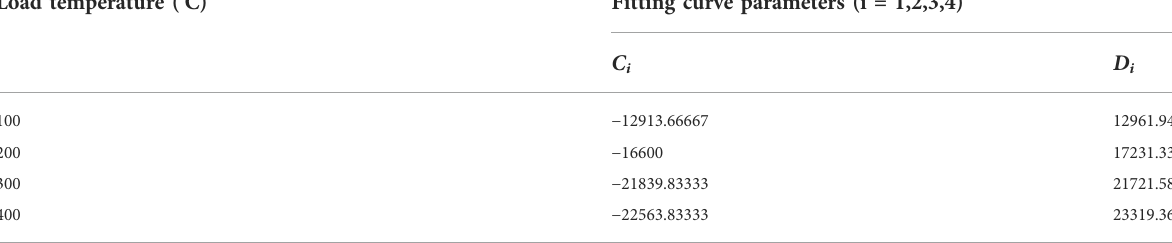
TABLE 4 Fitting curve parameters of number of cracks and soft rock thickness ratio under different